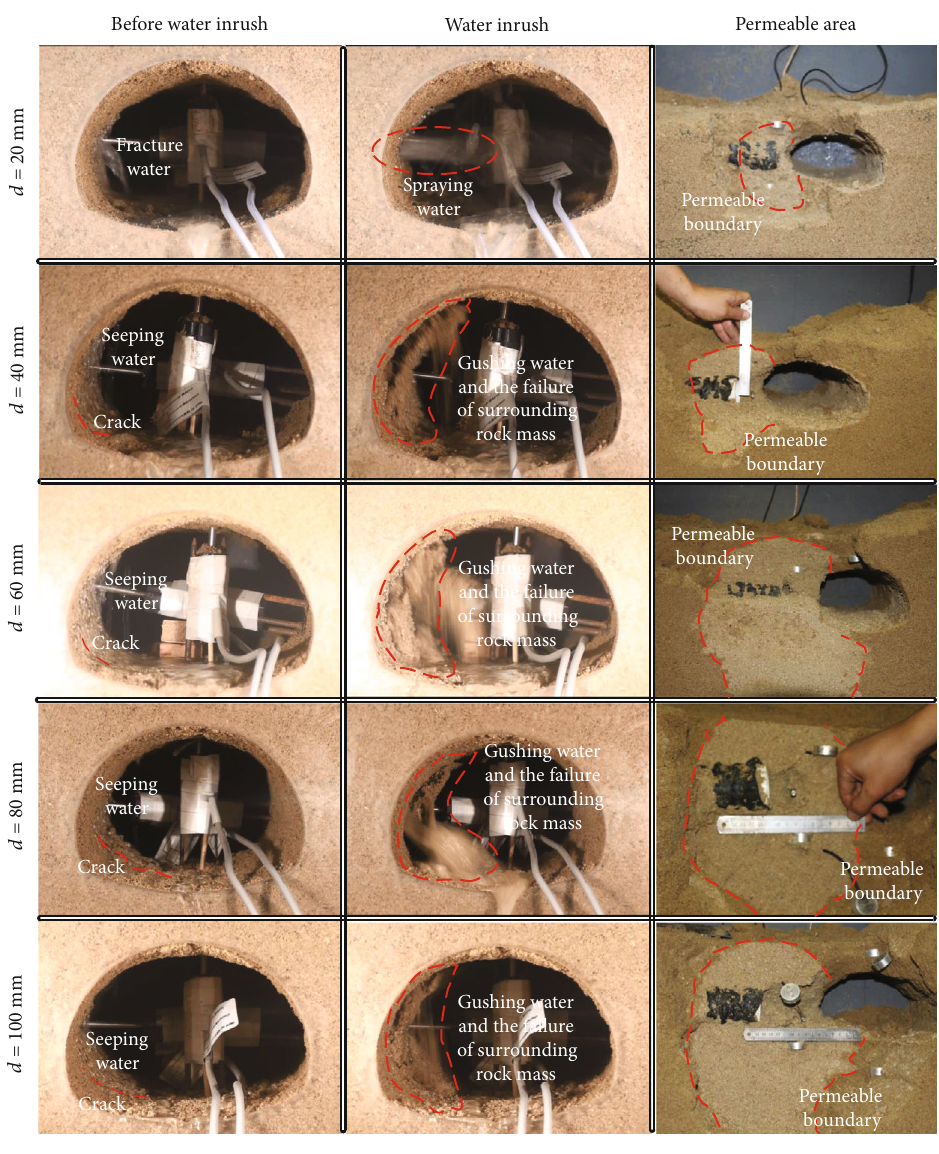
Figure 9: Water inrush and failure mode of